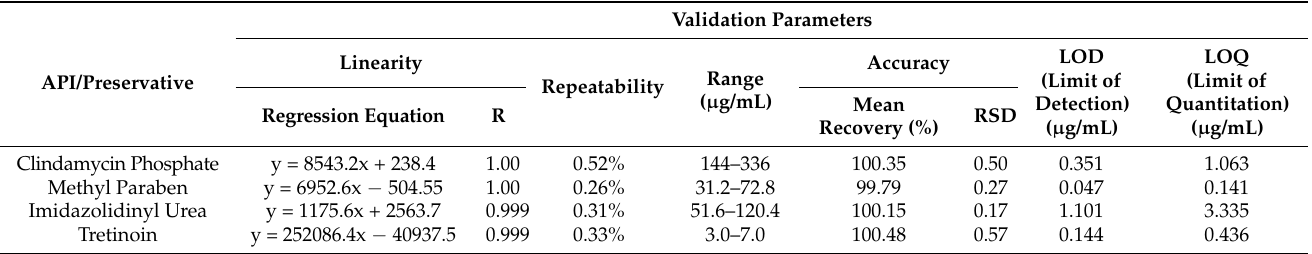
Table 2. Analytical performance data for the determination of the studied drugs by the proposed method.